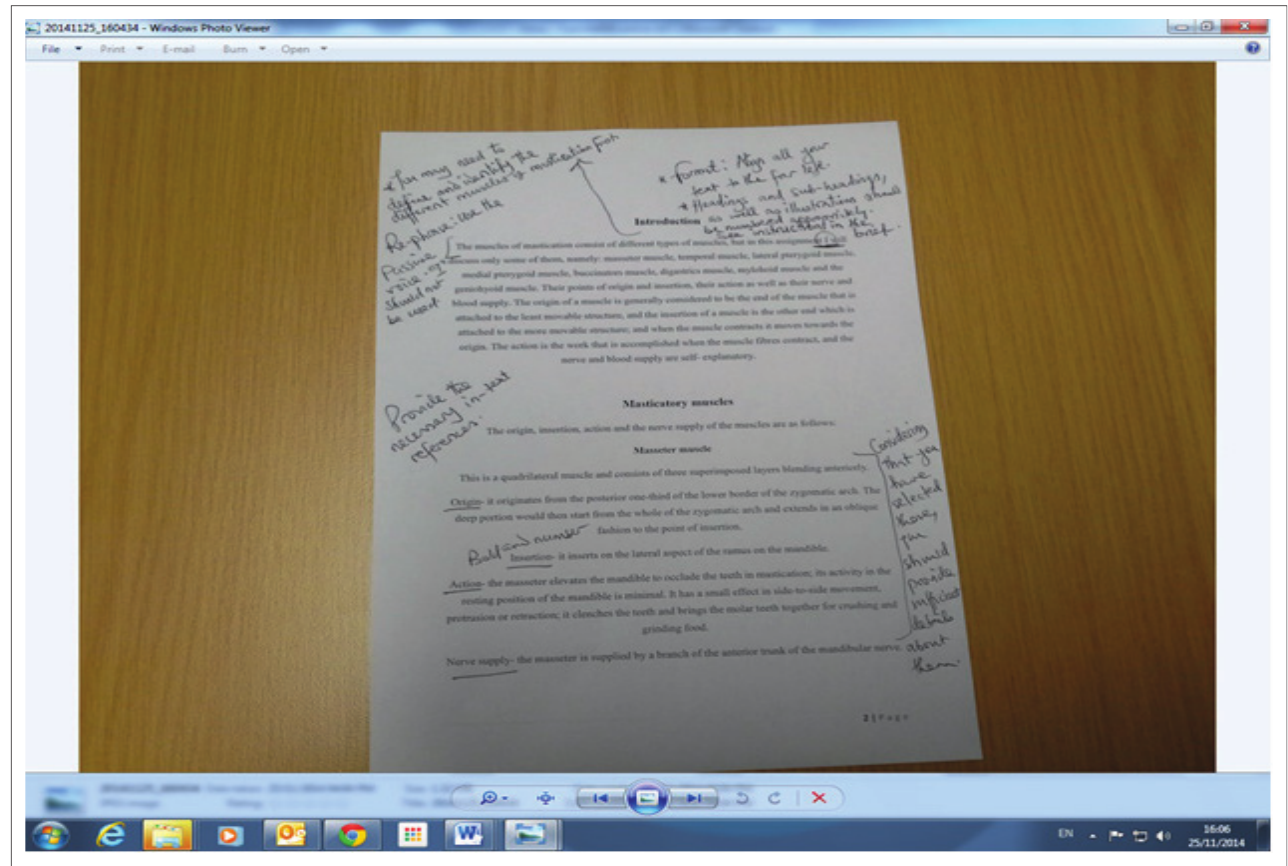
FIGURE 4: Implicit and explicit writing rules highlighted through formative